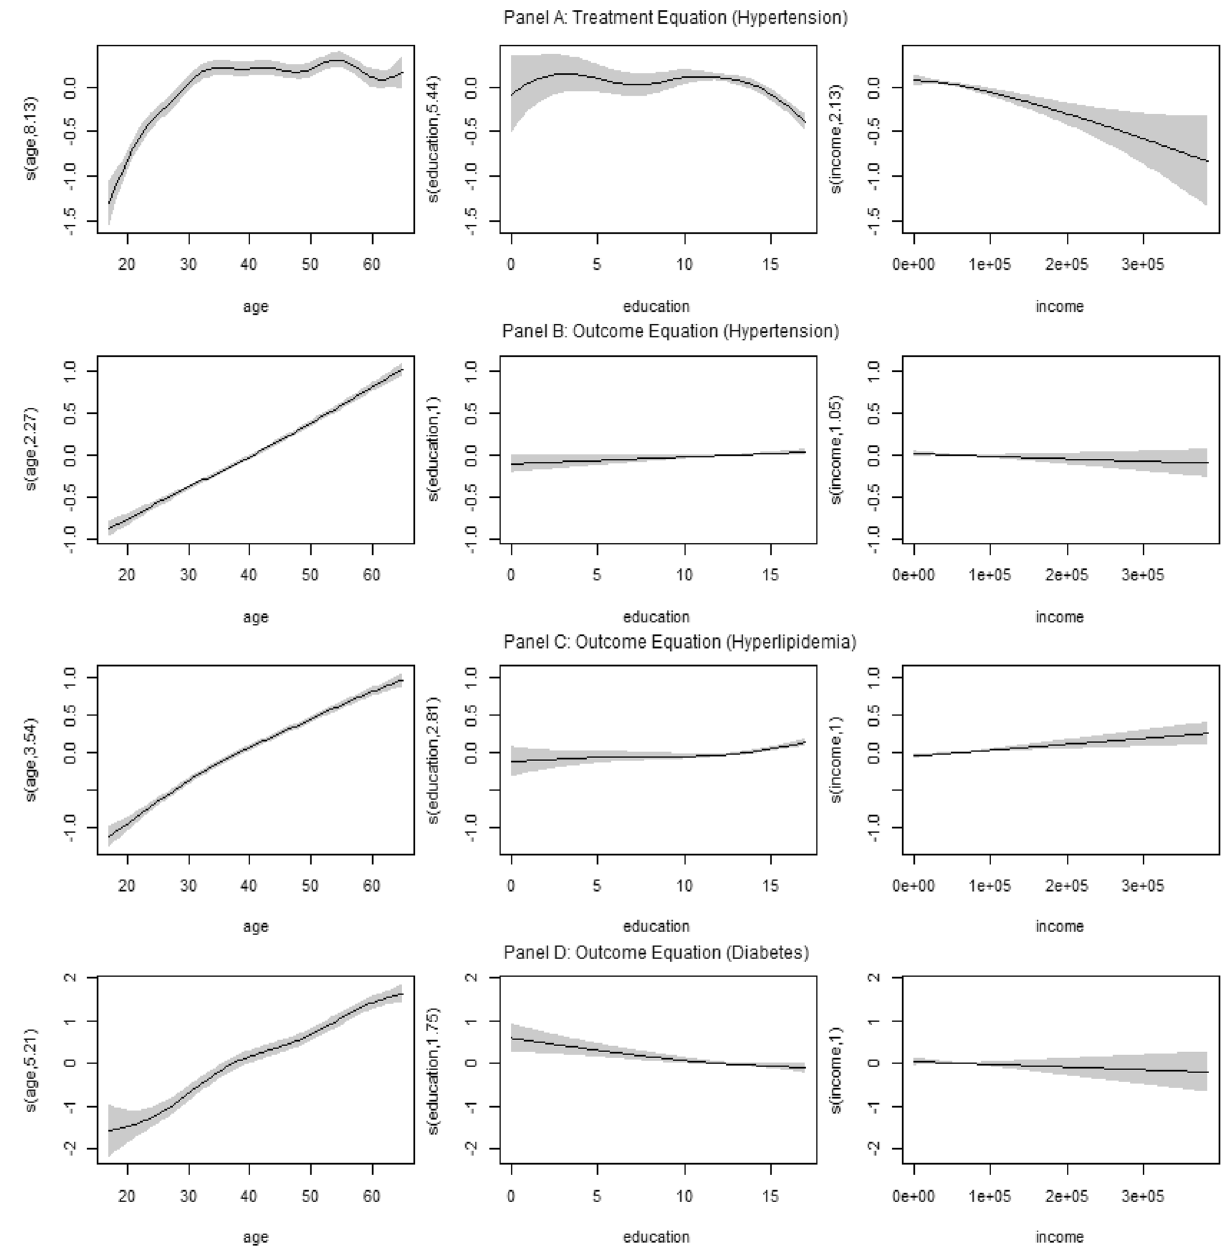
Figure 1. Smooth function estimates and associated 95 point-wise confidence intervals for obesity and all chronic diseases analyzed after applying the gjrm() function in GJRM to the MEPS data. The graph of the treatment equation (Obesity) is showed in Panel ( A ), while those for the outcome equations: Hypertension, Hyperlipidemia and Diabetes are showed in Panels ( B ), ( C ) and ( D )